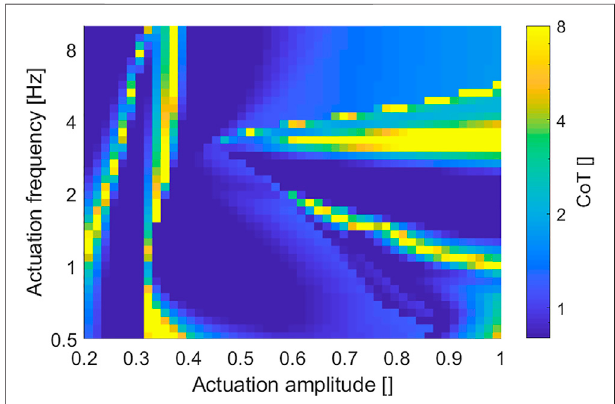
FIGURE 7 | Overview of the robot locomotion CoT under different actuation amplitudes and frequencies (the overall CoT range is suppressed to show more low CoT